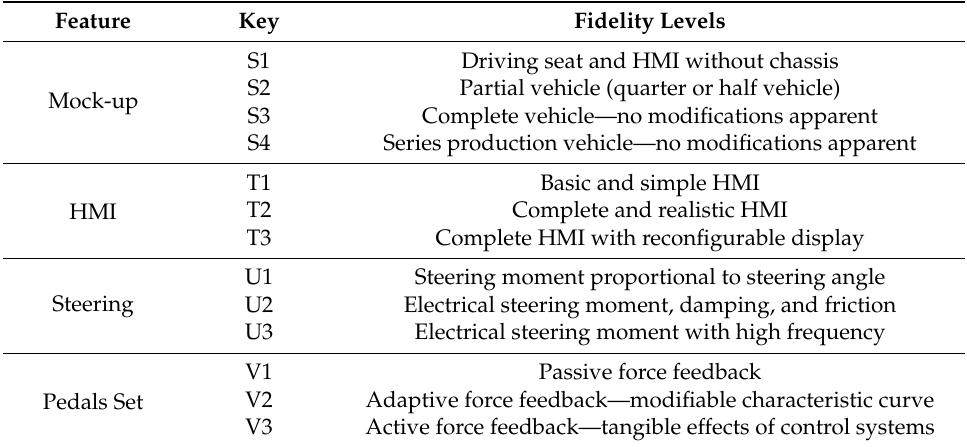
Table 1. Features and fidelity levels of the driver’s platform [6].